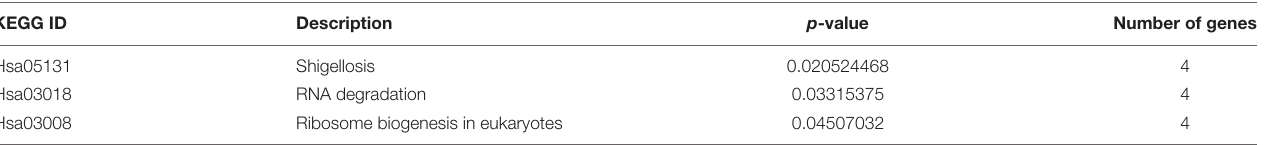
TABLE 2 | KEGG enriched pathways associated with FAM83 family members and their 259 co-expression genes in STAD patients ( P <